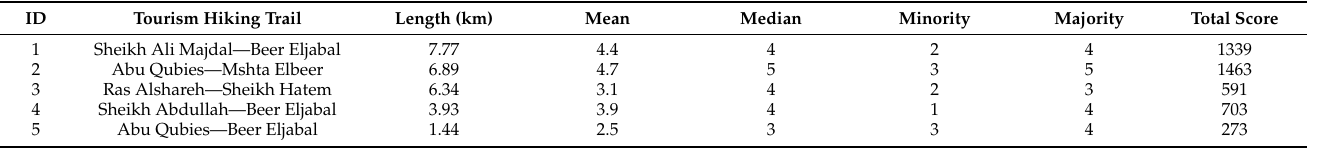
Table 3. Ranking of the tourism hiking trails in Abu Qubies based on ecosystem services values.